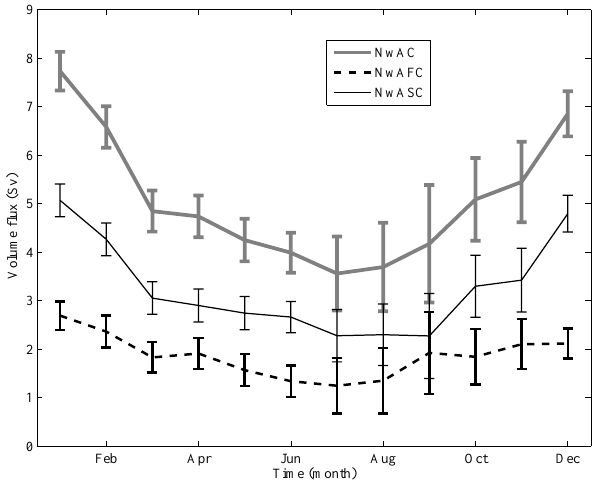
Fig. 8. Monthly values of volume flux in NwASC, NwAFC and NwAC with error